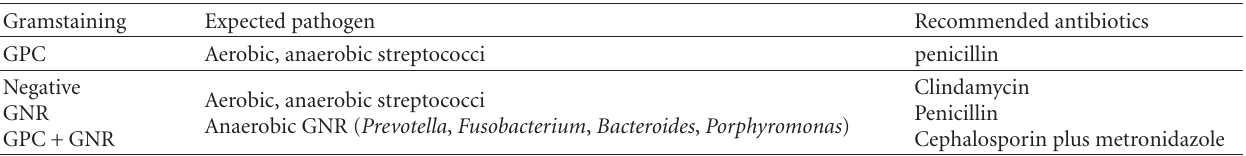
Table 5: Gram staining and recommended